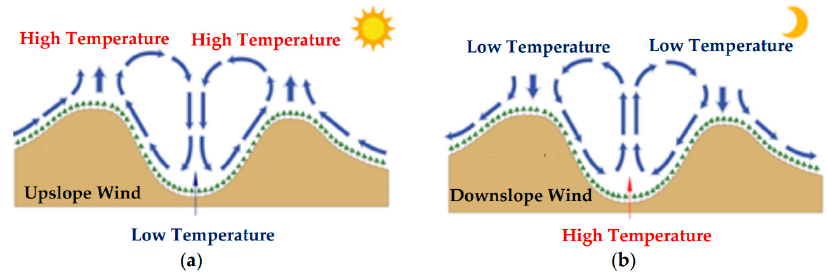
Figure 1. Mechanism of wind: ( a ) upslope; ( b ) downslope.